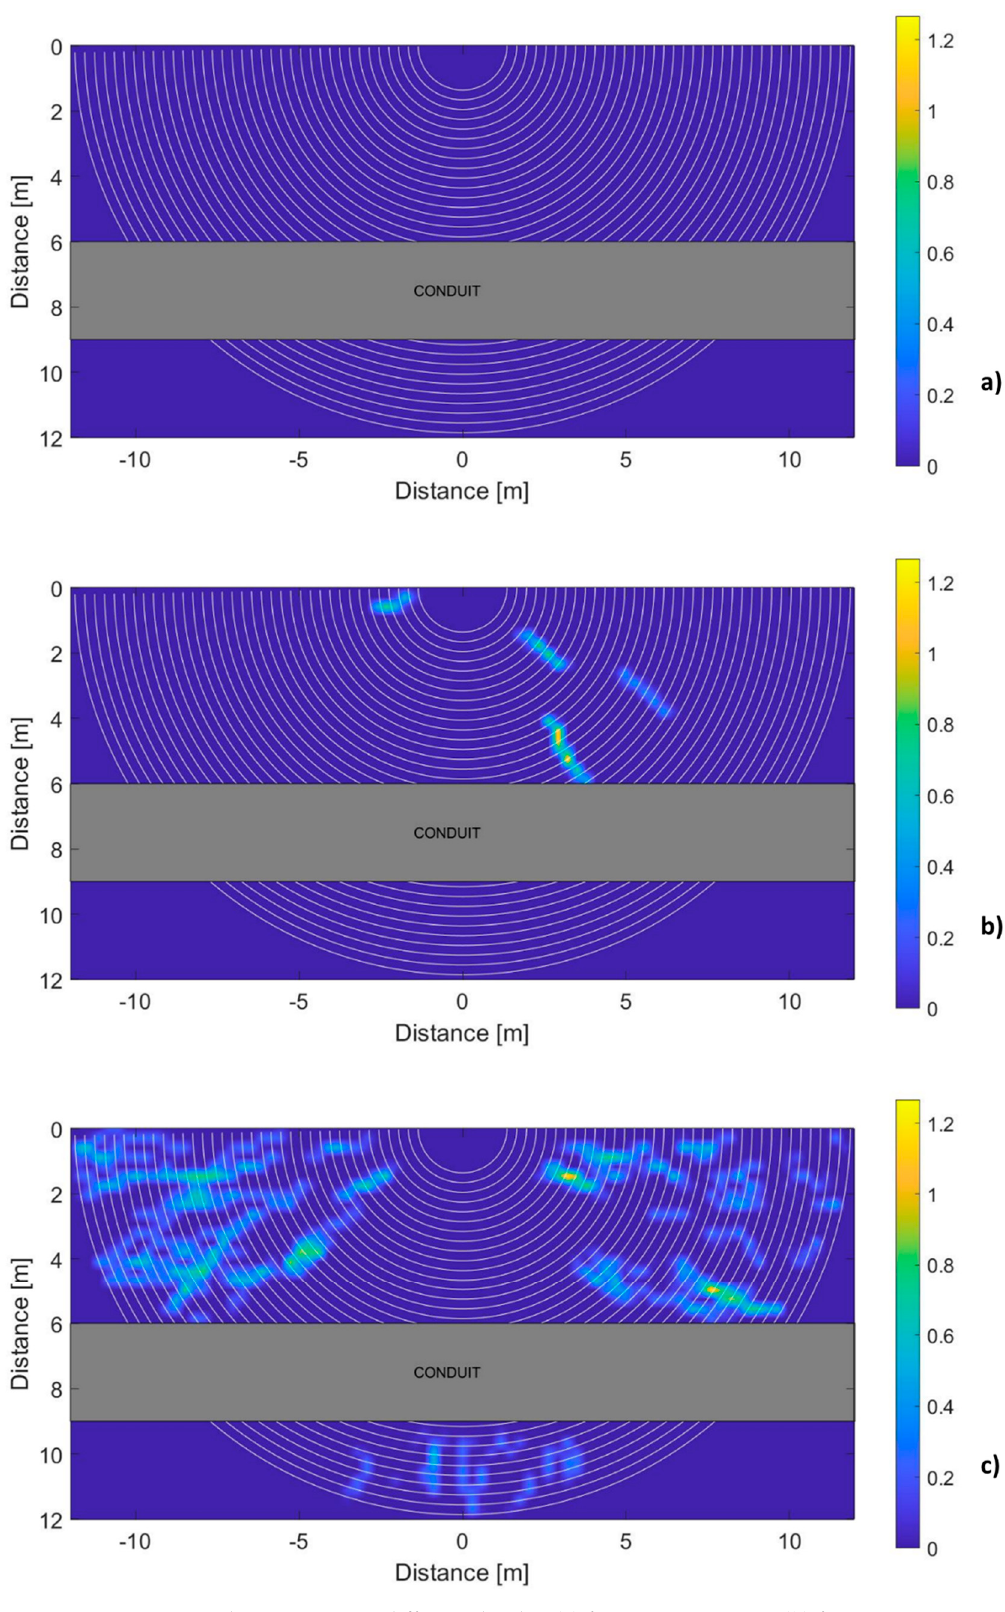
Figure 13. Root mass density maps at different depths: ( a ) from 0 m to 0.10 m, ( b ) from 0.10 m to 0.20 m, and ( c ) from 0.20 m to 0.30 m.